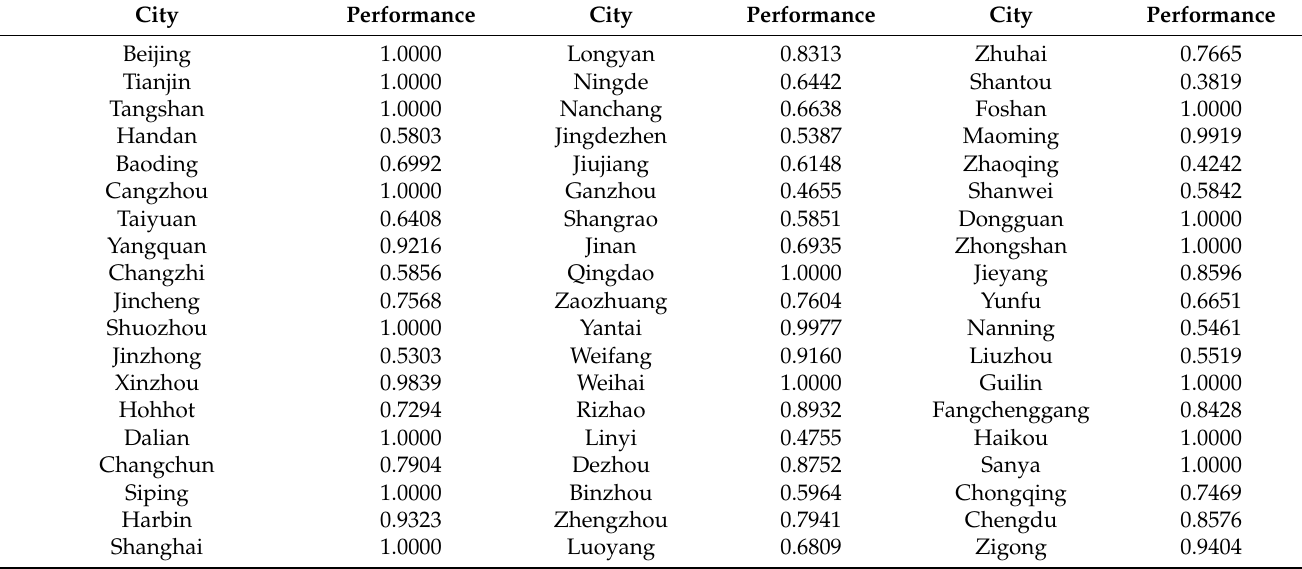
Table 3. The measurement results of energy performance of prefecture level cities in China in the environmental dimension.